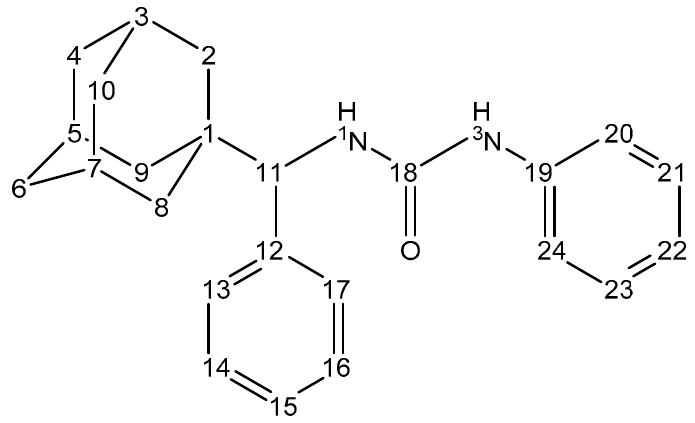
Figure 2. Carbon atoms labeled for compounds 8a – e , 8g – j , 10b and 10c . ( ± )-1-((Adamantyl)(phenyl)methyl)-3-phenyl urea ( 8a ). Method A. To 200 mg (0.75 mmol) 1-(isocyanato(phenyl)methyl)-3,5-dimethyl -adamantane ( 5a ) in 5 mL of diethyl ether, 80 mg (0.79 mmol) of triethylamine and 70 mg (0.75 mmol) of aniline ( 7a ) were added. The reaction mixture was exposed at room temperature for 12 h. After adding 5 mL of 1 N HCl, the mixture was stirred for 1 h. The precipitated white residual matter was filtered and washed with water. The product was purified by recrystallization from ethanol. Yield of 189 mg (70%), m.p. 253–254 ◦ C. Method B . To 200 mg (0.72 mmol) hydrochloride 1-[adamantyl(phenyl)methyl] -amine ( 6a ) in 5 mL of diethyl ether, 160 mg (1.58 mmol) of triethylamine and 70 mg (0.75 mmol) of phenylisocyanate ( 9a ) were added. The reaction mixture was exposed at room temperature for 12 h. After adding 5 mL of 1 N HCl, the mixture was stirred for 1 h. The precipitated white residual matter was filtered and washed with water. The product was purified by recrystallization from ethanol. The yield is 221 mg (85%), m.p. 253–254 ◦ C. 1 H NMR (300 MHz, DMSO- d 6 , δ ) ppm: 1.26–1.70 m (12H, Ad), 1.91 s (3H, Ad), 4.36 d (1H, Ad-CH(Ph)-, J = 9.2 Hz), 6.76–6.92 m (2H, Ad-CH(Ph)-NH-C(O)-NH-Ph-4H), 7.08–